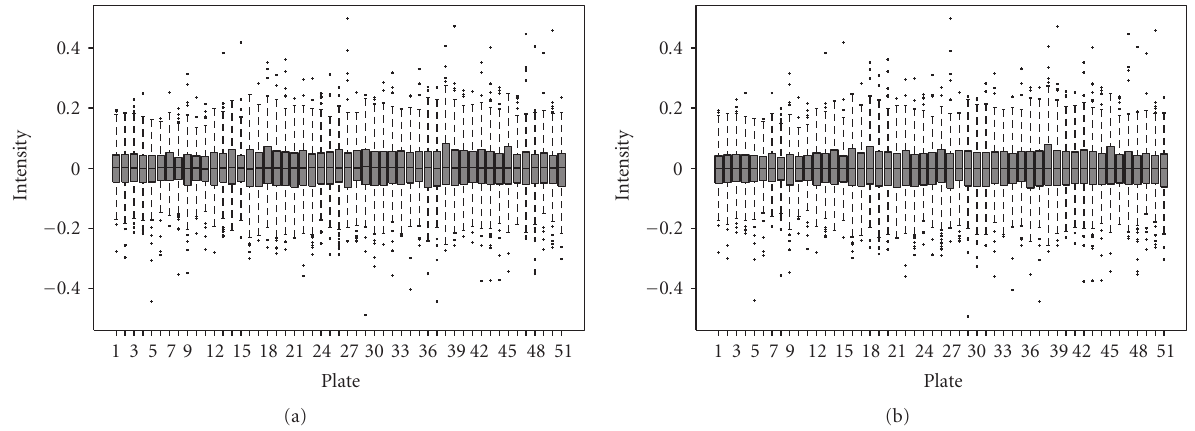
Figure 7: Spotting process: plate: the box plot showing the distribution of log T/C values for each plate (a) before correction and (b) after correction by median